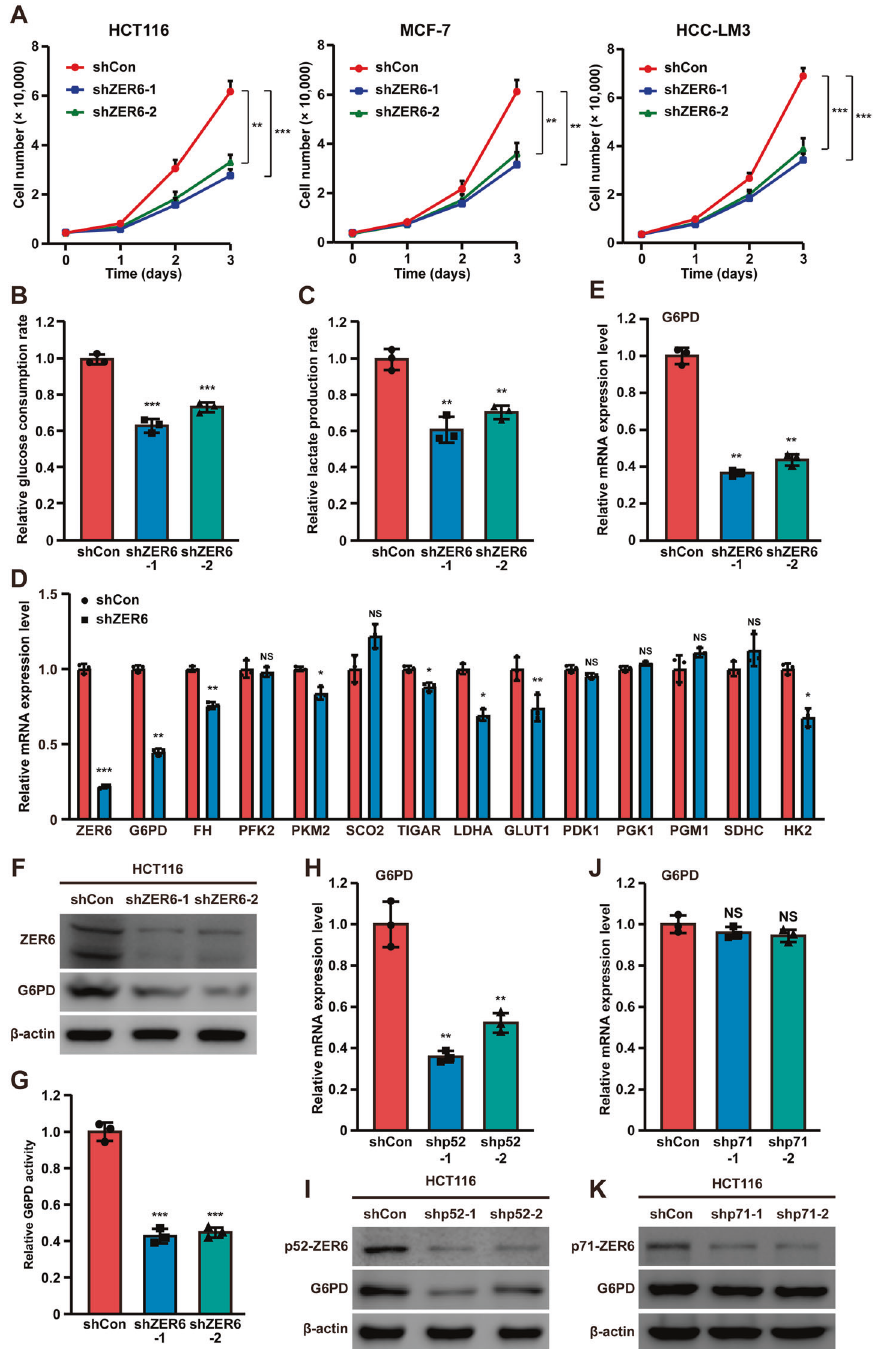
Fig. 1 ZER6 alters tumor cells glucose metabolism. A Viability of ZER6 -silenced HCT116, MCF-7 and HCC-LM3 cells at indicated time points. B , C Glucose consumption ( B ) and lactate production ( C ) levels in ZER6 -silenced HCT116 cells. D mRNA expression levels of glucose metabolism-related genes in ZER6 -silenced HCT116 cells, as analyzed using quantitative real-time PCR (qRT-PCR). E , F G6PD mRNA ( E ) and protein ( F ) expression levels in ZER6 -silenced HCT116 cells, as analyzed using qRT-PCR and western blotting, respectively. G G6PD enzymatic activity in ZER6 -silenced HCT116 cells. H, I G6PD mRNA ( H ) and protein ( I ) expression levels in p52-ZER6 -silenced HCT116 cells, as analyzed using qRT-PCR and western blotting, respectively. J , K G6PD mRNA ( J ) and protein ( K ) expression levels in p71-ZER6 -silenced HCT116 cells, as analyzed using qRT-PCR and western blotting, respectively. Cells transfected with shCon were used as controls. β -actin was used for qRT-PCR normalization and as western blotting loading control. Total protein was used for normalizing the levels of glucose consumption, lactate production, and G6PD enzymatic activity. Quanti fi cation data are expressed as mean ± SD ( n = 3). shZER6: shRNA expression vector targeting ZER6 ; shp52: shRNA expression vector targeting p52-ZER6 ; shp71: shRNA expression vector targeting p71-ZER6 ; * P < 0.05; ** P < 0.01; *** P < 0.001; NS not signi fi